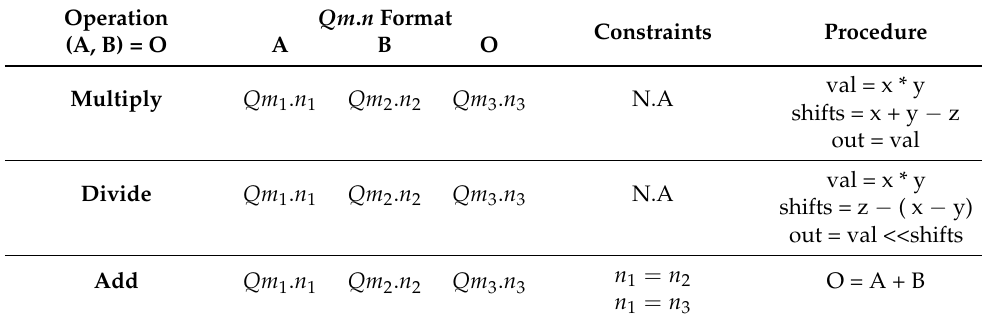
Table 4. Quantized